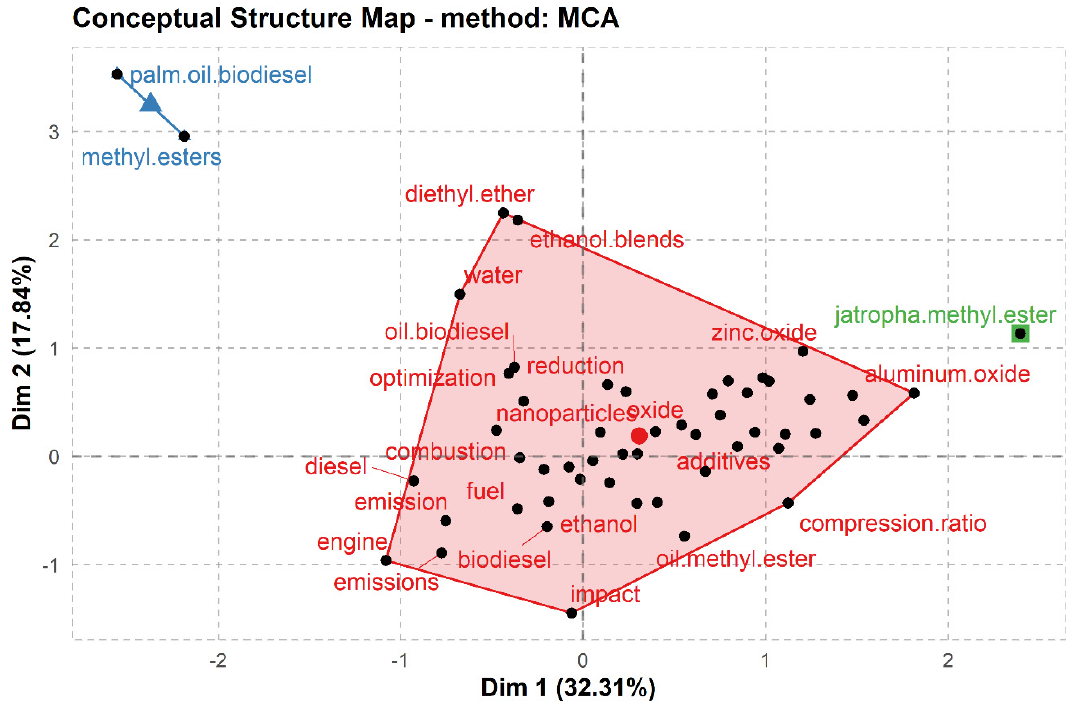
Figure 3. Conceptual structure plot using Multiple Correspondence Analysis (MCA).